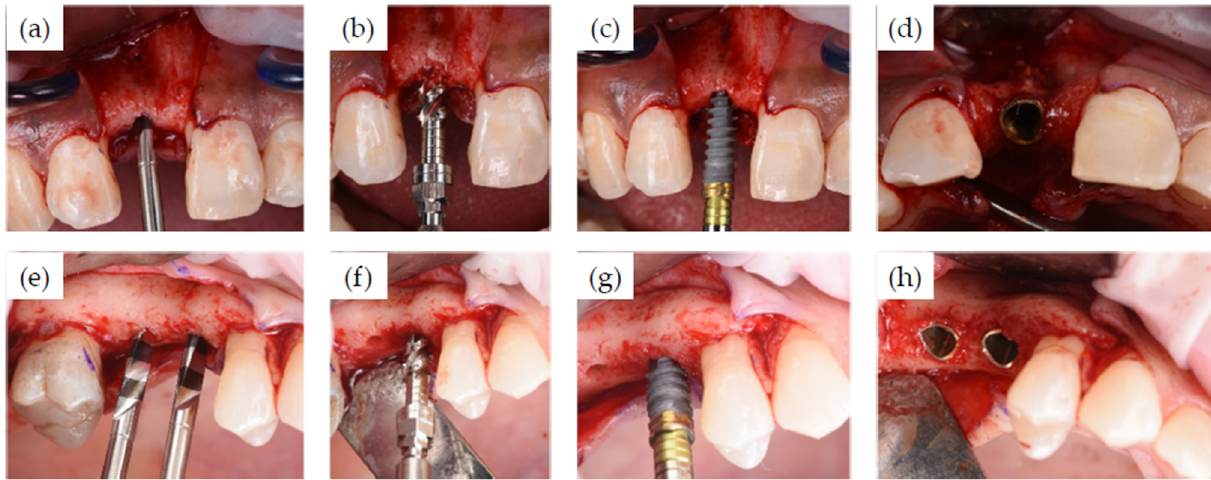
Figure 5. Implant site preparation and implant insertion. ( a – d ) Implant site preparation with the pilot drill ( a ), followed by the osseoshaping tool ( b ), and implant insertion ( c ) with the final insertion torque of 55 Ncm. ( d ) Occlusal view of implant in place. ( e – h ) After establishing the initial osteotomy with the pilot drill ( e ), the site was prepared with the osseoshaping tool ( f ). The sinus lift procedure was performed using osteotomes, and the implant was inserted ( g ) with a final insertion torque of 70 Ncm. ( h ) Occlusal view immediately after post-implant placement.